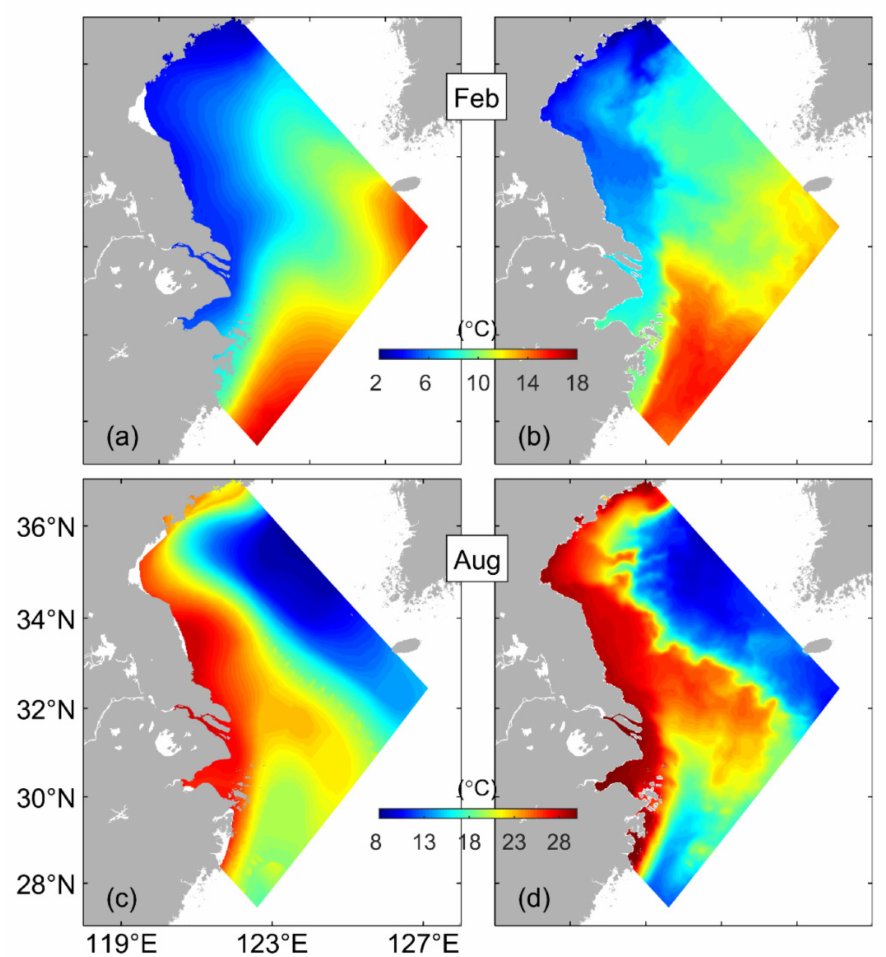
Figure 6. Monthly mean sea bottom temperature (SBT) in February ( a , b ) and August ( c , d ) computed from ( a , c ) the Marine Atlas and ( b , d ) the inner model results in 2015 in the case of